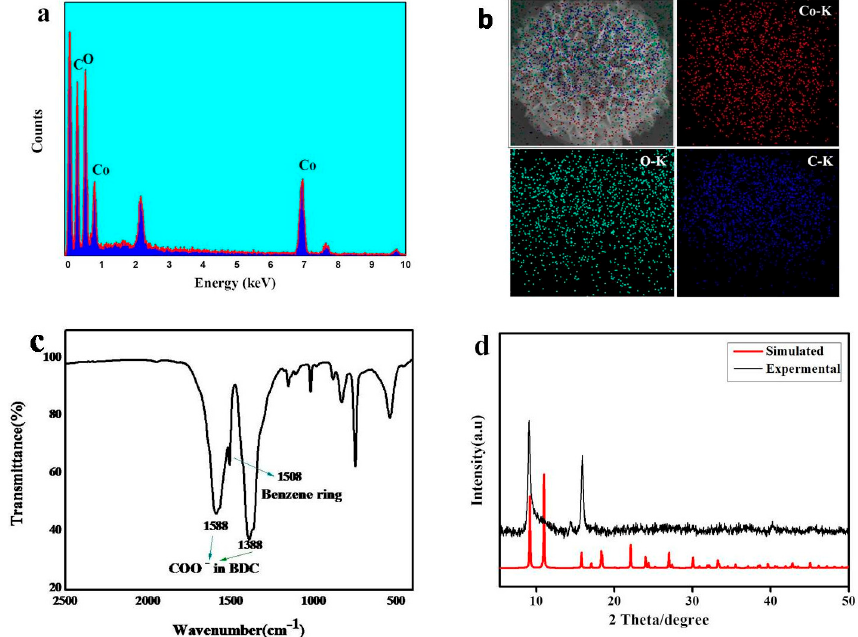
Figure 2. EDS spectrum ( a ); elemental mapping image ( b ); FT-IR spectrum( c ) and XRD ( d ) of Co/BDC CP microparticles fabricated in the solvent of the ternary mixture. The structure of the simulated 3D reference was shown in Figure S3.